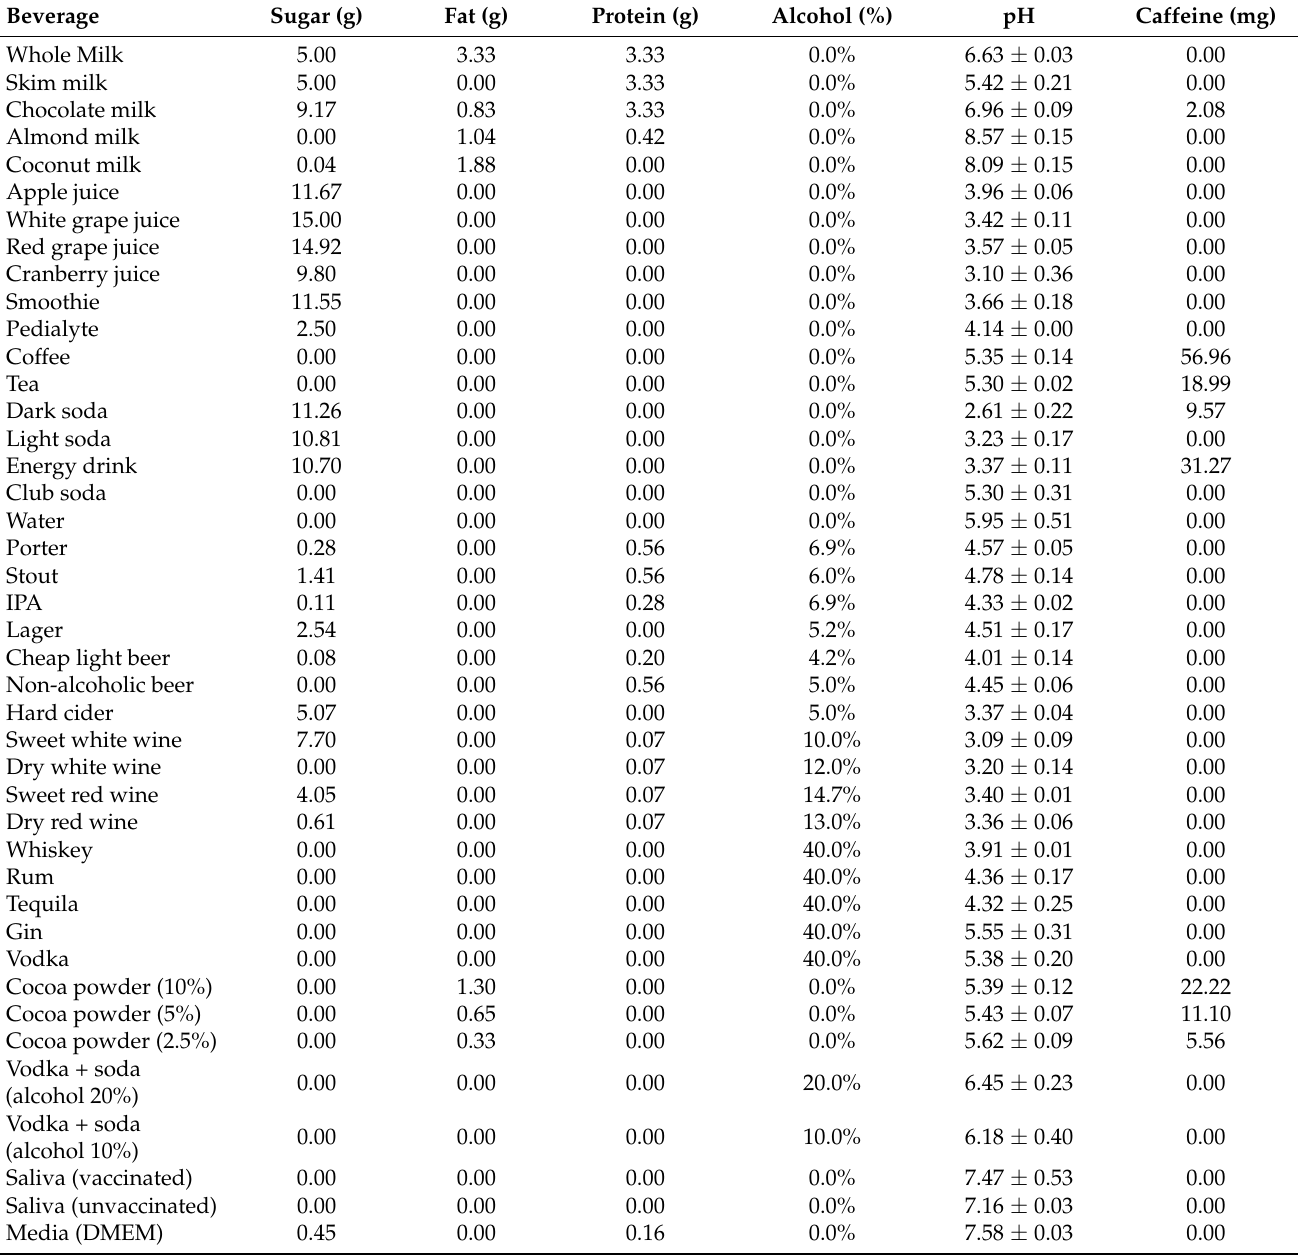
Table 1. Beverage characteristics (per 100